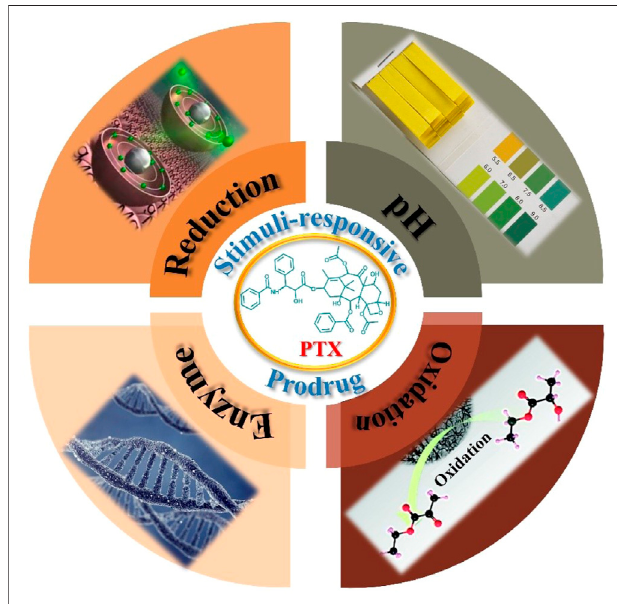
FIGURE 1 | Four types of polymer-PTX prodrug